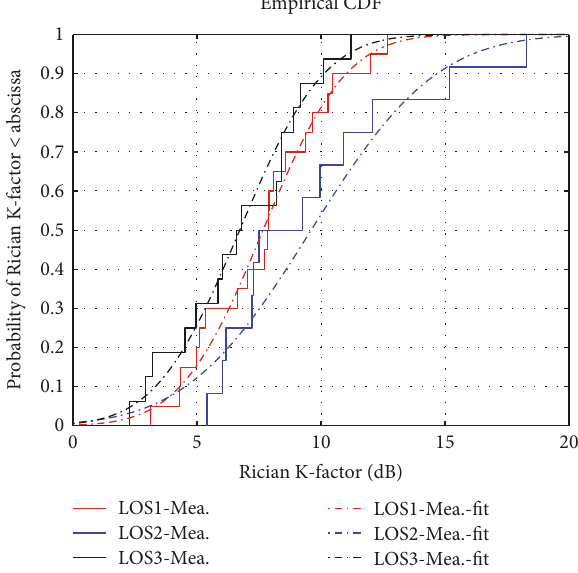
Figure 8: CDF for Ricean K-factor in LOS tunnel scenarios.